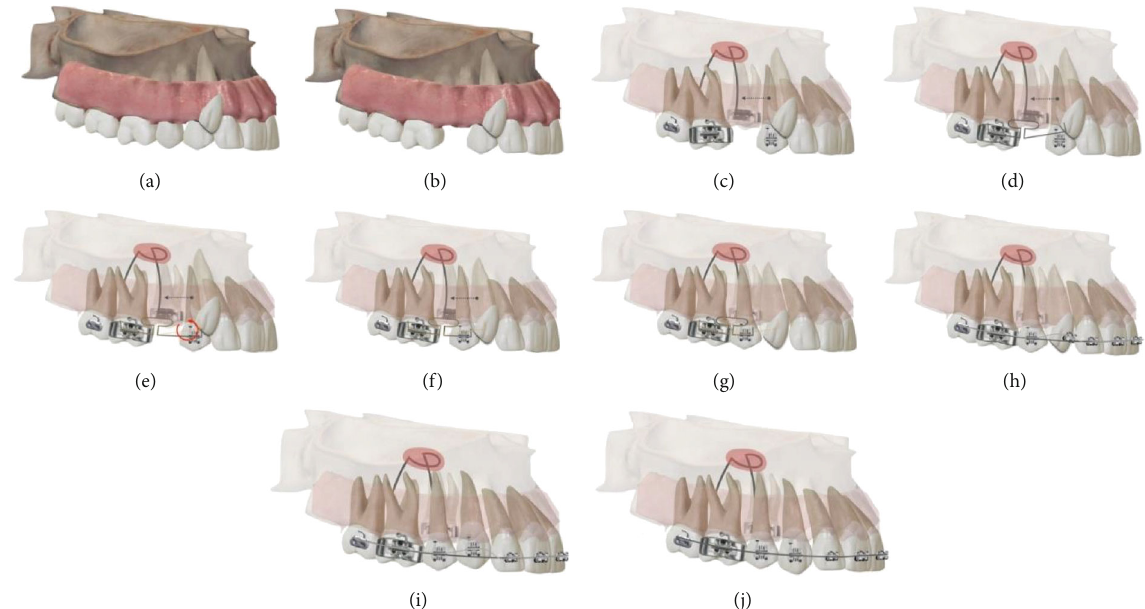
Figure 11: Illustration showing simulated movement of the ectopic canine into occlusion in a similar scenario following extraction of #15 (b). A segmented T loop being used for retraction of #14 into the extraction space and the transseptal fi bers of #13 following #14 into occlusion (c – g). Overlay archwire to derotate and get #13 into alignment (h, i). Finishing on a 0 : 019 ″ × 0 : 025 ″ stainless steel